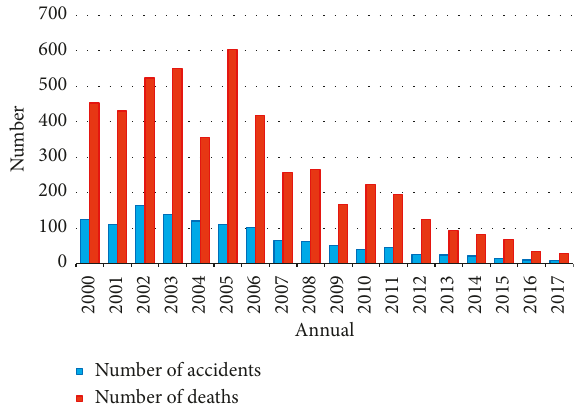
Figure 1: Coal mine water disasters in China between 2000 and